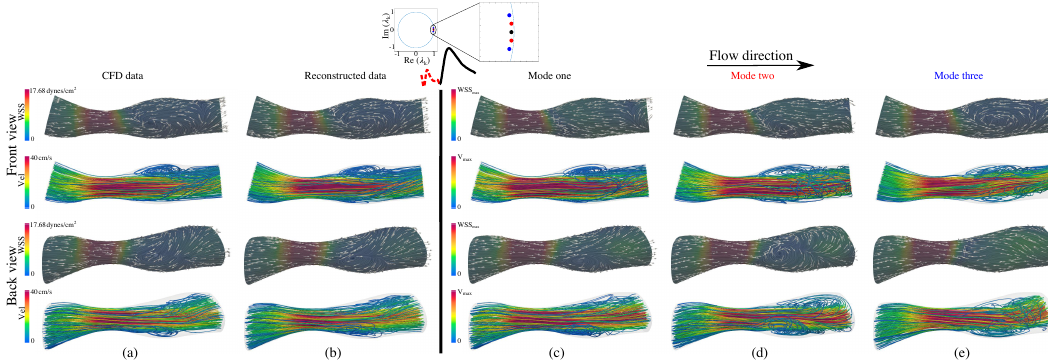
Figure 5. Velocity and wall shear stress (WSS) computational fluid dynamics (CFD) data and the multistage DMD with control (mDMDc) modes are shown in the first stage of the coronary artery stenosis model. The stage is highlighted with a red dashed line in the flow waveform. The location of discrete eigenvalues in the unit circle corresponding to the selected mDMDc modes are shown. Velocity and WSS streamlines are shown and colored by their magnitude. WSS vectors are normalized and shown on top of the WSS streamlines to show the WSS vector direction. ( a ) CFD data (time = 0.11 s), ( b ) reconstructed data with 95% accuracy, ( c ) real part of the mDMDc mode corresponding to the eigenvalue λ = 0.99, ( d ) real part of the mDMDc mode corresponding to the eigenvalue λ = 0.99 ± 0.04 i , ( e ) real part of the mDMDc mode corresponding to the eigenvalue λ = 0.98 ± 0.08 i